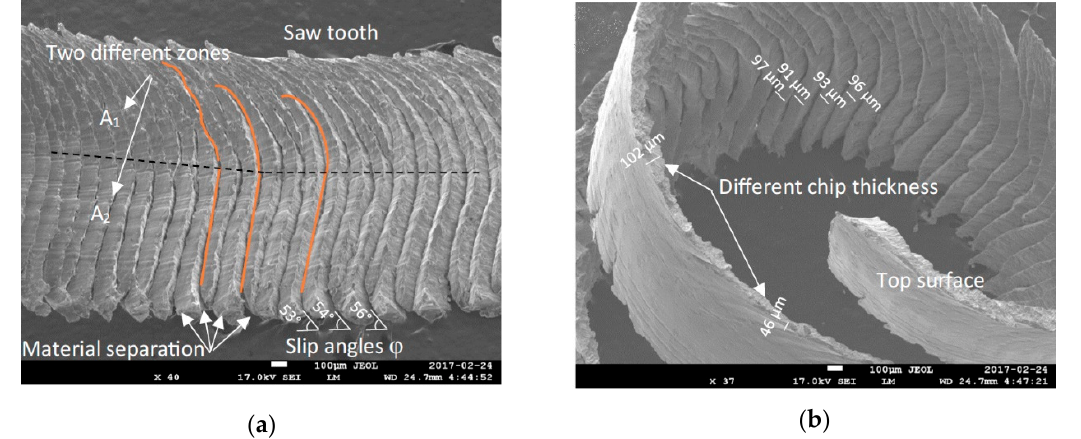
Figure 5. ( a ) two distinct zones with two different compression ratios; ( b ) different shear slip distances [41] .